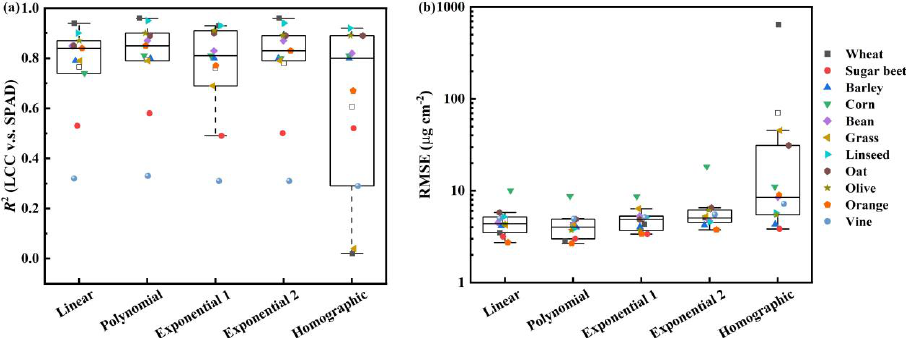
Figure 3. The assessments of five functions for the estimation of the LCC of each species across all field datasets with the R 2 ( a ) and RMSE ( b ). Exponential 1 is the exponential function LCC = a ∗ e b ∗ SPAD , and Exponential 2 is the exponential function LCC = 0.0893 ∗ (10 SPAD 𝛼 ) . Central lines represent the medians, boxes represent 50% of the data, squares represent mean values, whiskers represent minimum and maximum values, and symbols outside the whiskers represent outliers.